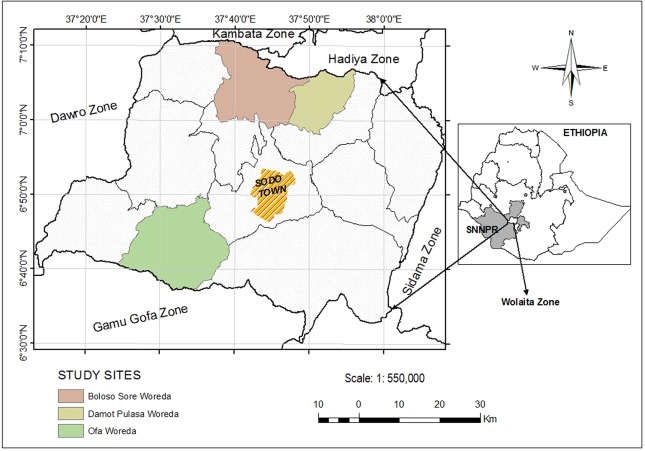
Map of study area.